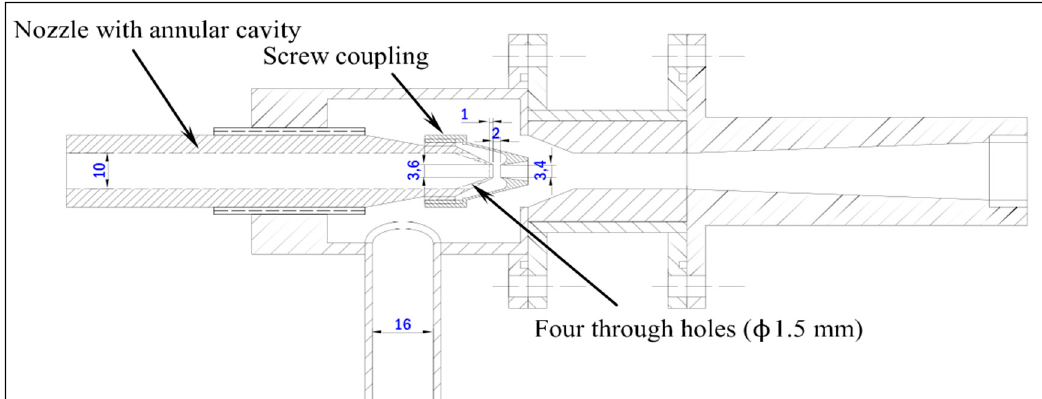
Figure 8. Bypass ejector [36].